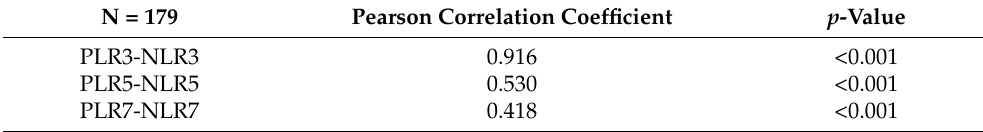
Table 5. Pearson correlation coefficients between PLR and NLR on postoperative days 3, 5, and 7. N =